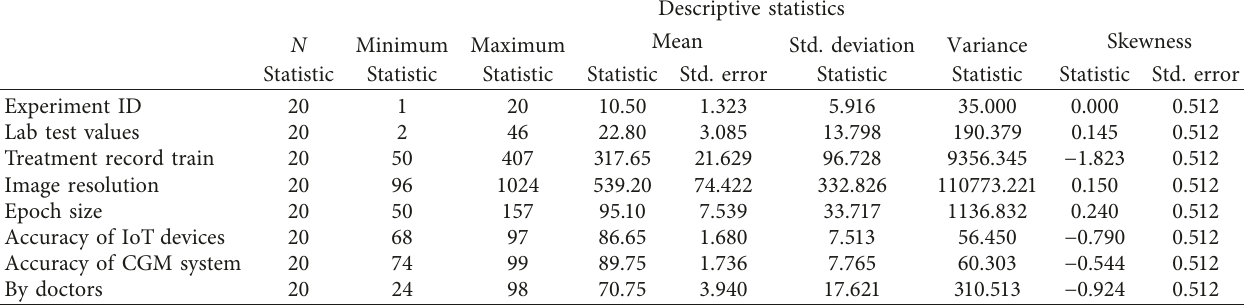
Figure 6: Research Table 1: Descriptive statistics.